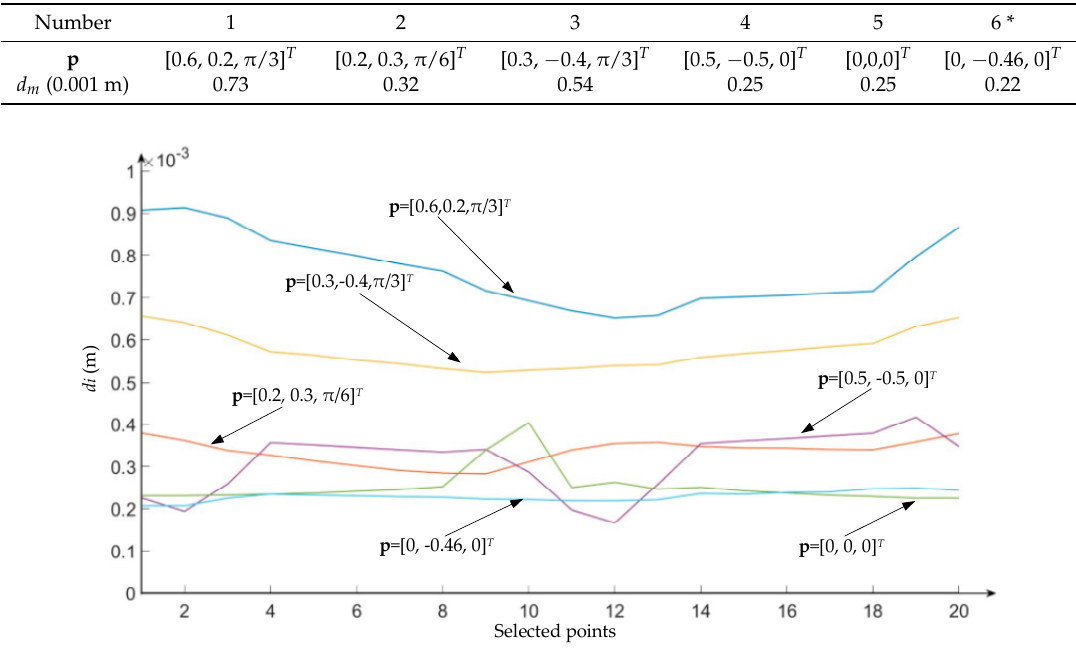
Table 2. d mi with different places of workpiece. * represents the set of result as the optimal workpiece pose.